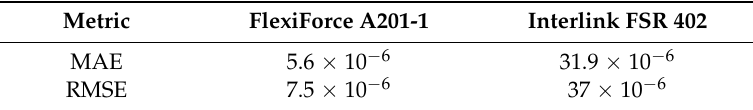
Table 4. Mean Absolute Error (MAE) and Root Mean Squared Error (RMSE) stemmed from model testing on the basis of Equation